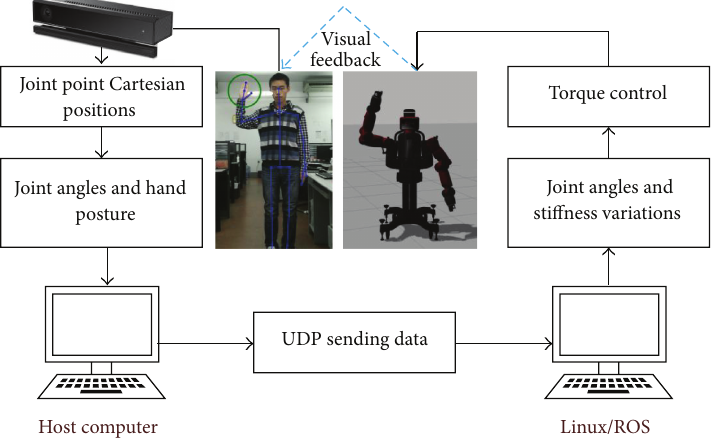
Figure 8: The simulation experiment flow